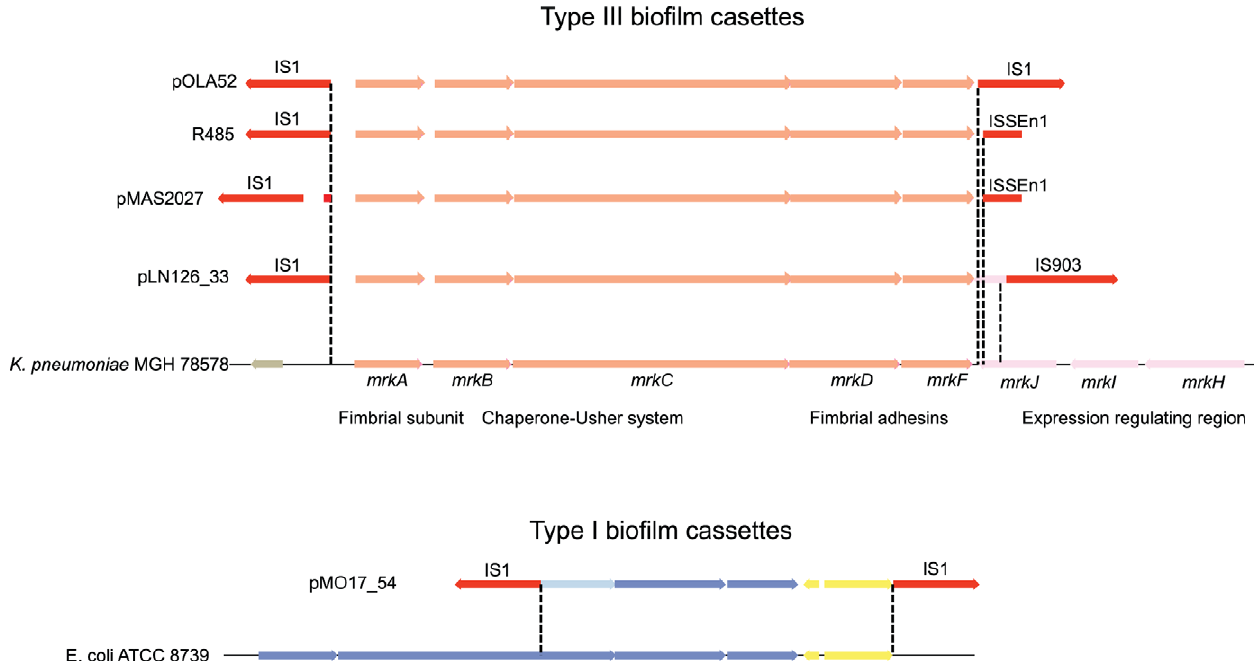
Figure 3. Fimbriae encoding gene cassettes. (top) The different versions of the mrkABCDF cassette and their flanking IS elements as they are arranged on plasmids pOLA52, R485, pMAS2027 & pLN126_33, compared to the corresponding chromosomal region of K. pneumoniae MGH 78578. (bottom) A similar comparison between the inserted region of plasmids pMO17/440_54 and the corresponding E. coli region that contains a putative type 1 fimbrial biogenesis